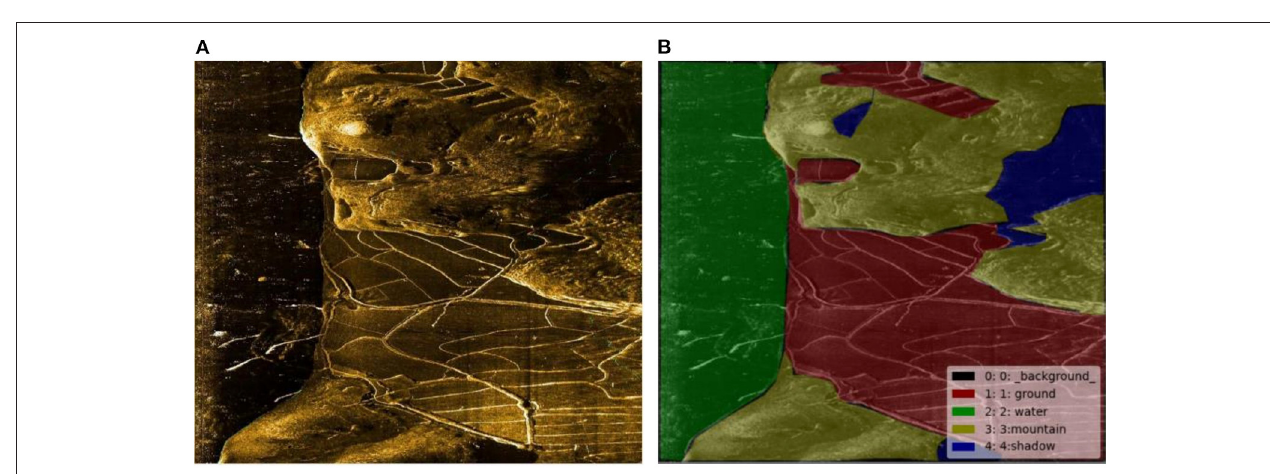
FIGURE 8 | (A) original image and (B)